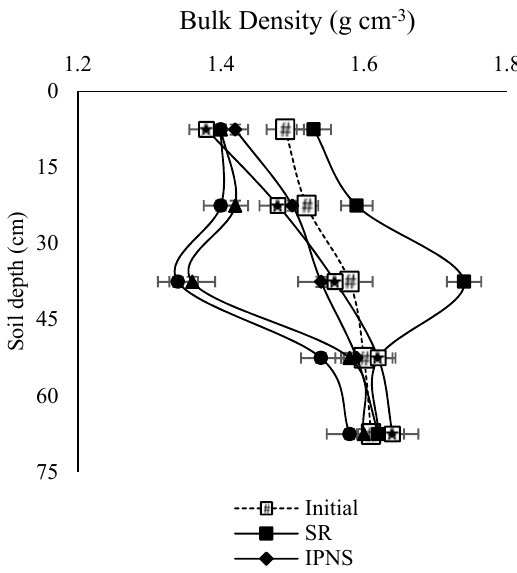
Figure 3. Changes in the bulk density of soil at different profile depths after 20 RWS cycles under the influence of different nutrient management options. Bars indicate the standard error of the mean, n = 4.